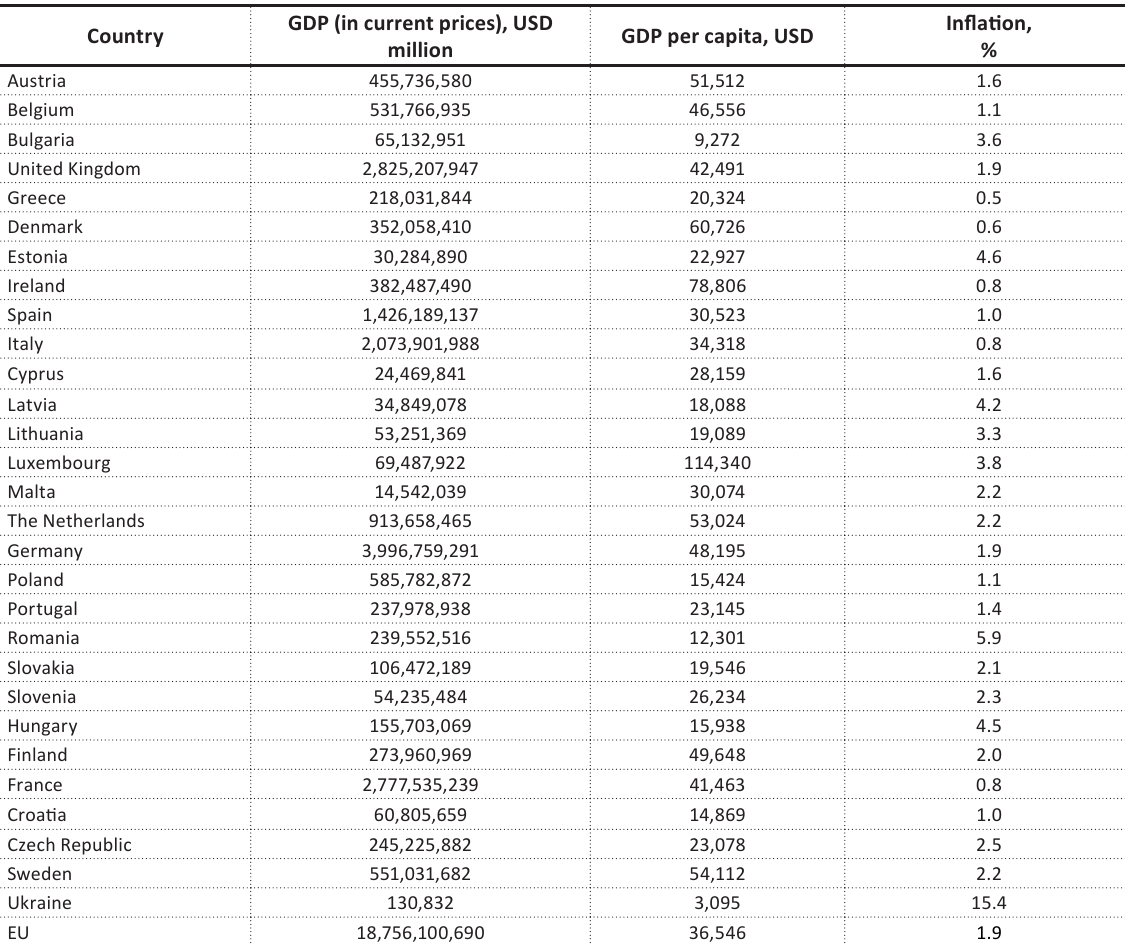
Source: World Bank Group